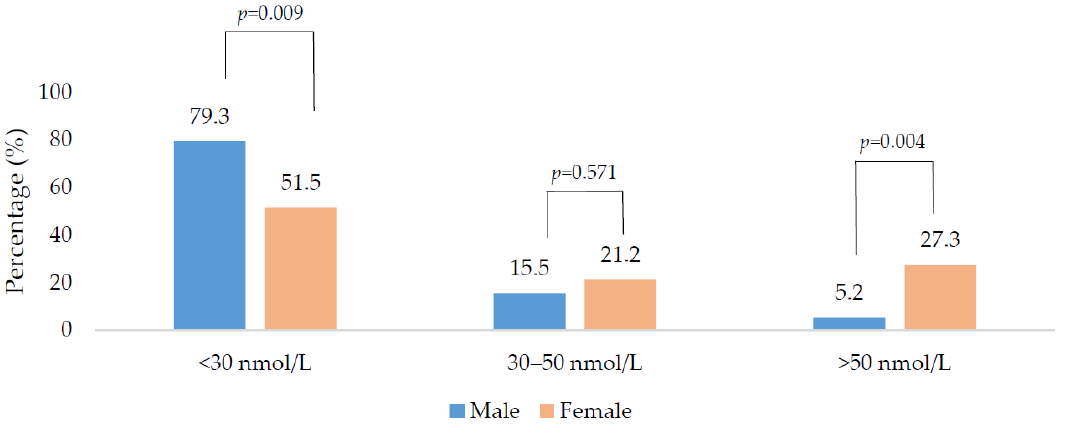
Figure 1. Vitamin D status of the population during the low vitamin D synthesis period (October to March) sub-divided by gender. p -values were derived from chi-square analysis.